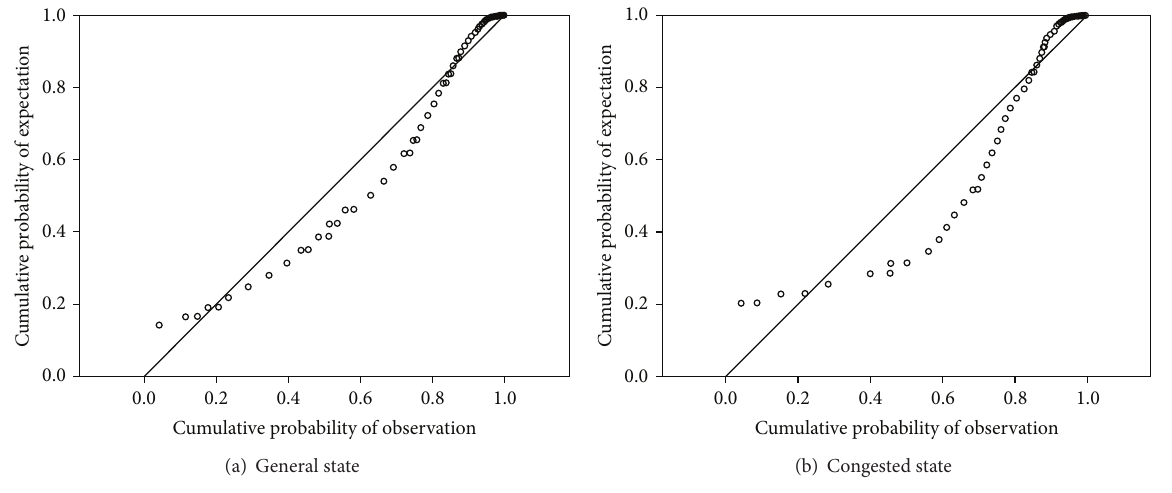
Figure 5: P-P figure of normal distribution fitting.